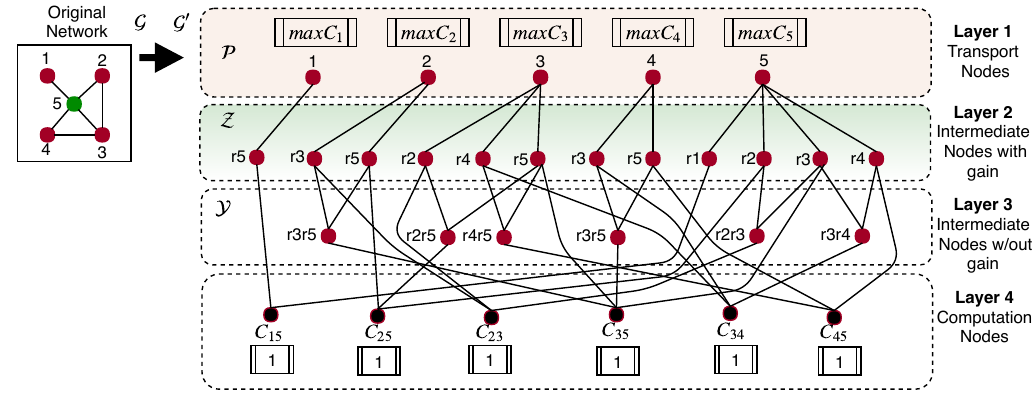
Figure 6. Network transformation